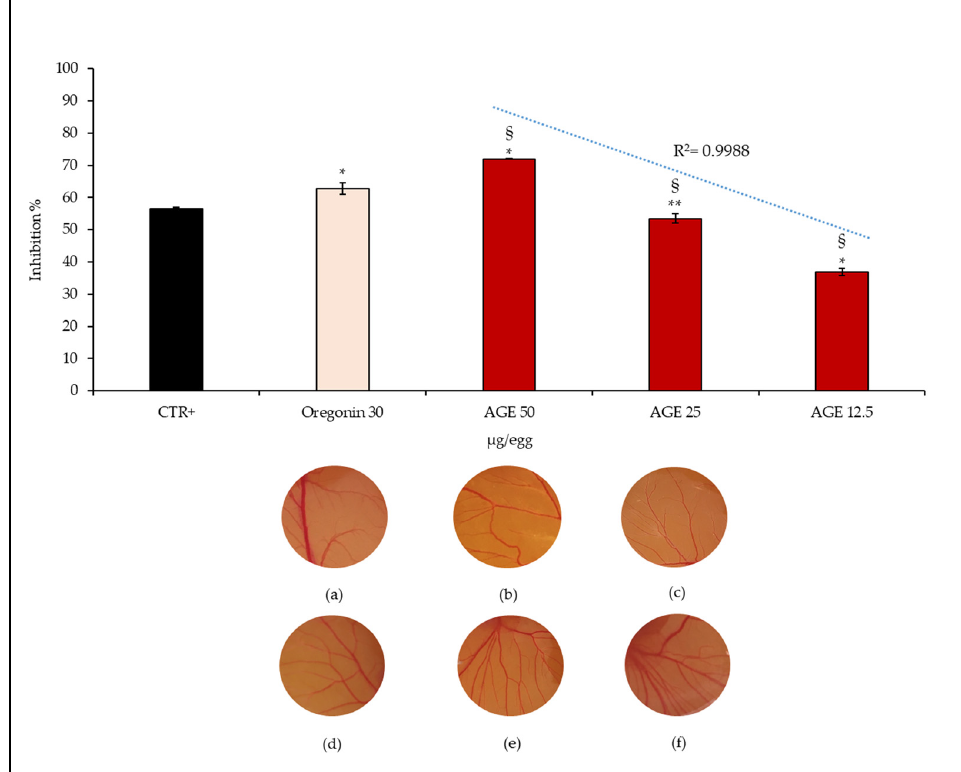
Figure 4. Anti-angiogenic properties of several concentrations of A. glutinosa bark extract (AGE) evaluated by CAM assay. In the figure, representative pictures of the CAMs after treatment with the positive control (retinoic acid, 1 µg/egg) ( a ), main bioactive compound of AGE at the same concentration present in the extract (oregonin, 30 µg/egg) ( b ), AGE 12.50–50 µg/egg ( c – e ) and negative control (deionized water) ( f ) were reported. The graph bar shows the linear correlation coefficient (R 2 ), which highlights the concentration-dependent behavior of AGE. Results were expressed as mean inhibition percentage ± standard deviation of five independent experiments ( n = 5). * < 0.001 vs. positive control (CTR+); ** < 0.05 vs. CTR+; § < 0.001 vs. oregonin 30 µg/egg.